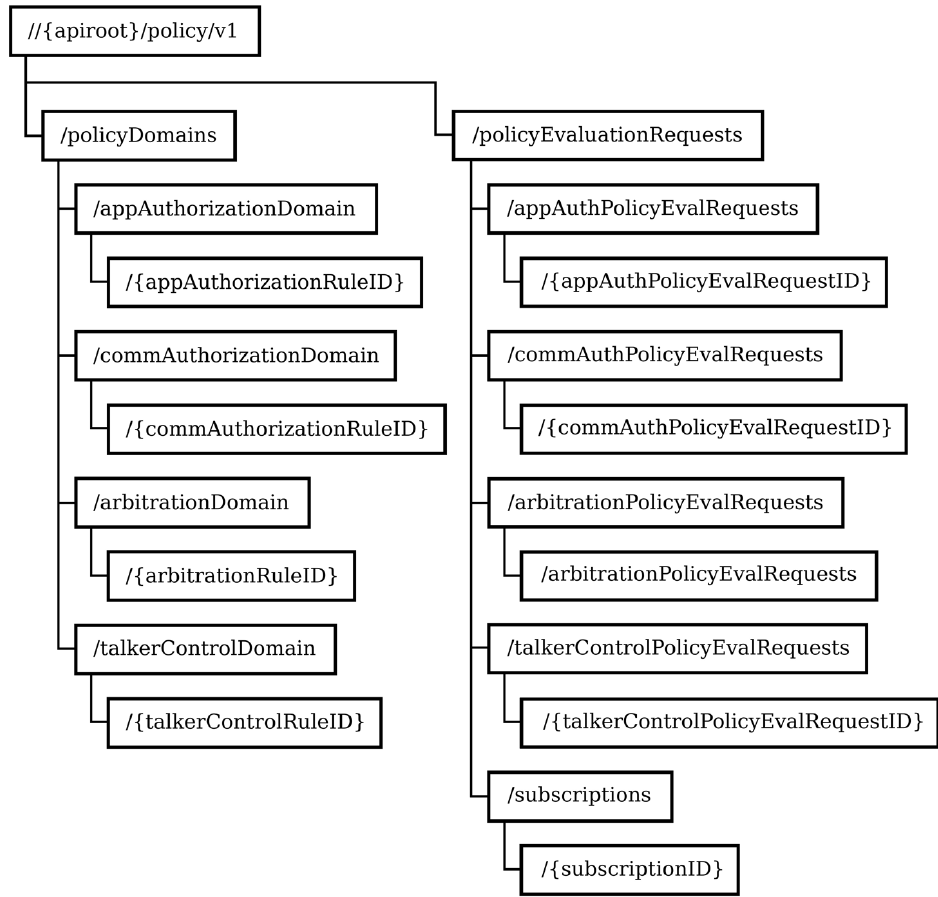
Figure 1. The structure of the URIs of the policy service resources. The policyDomains resource represents the defined railway policy domains. The GET method applied to this resource retrieves the list of policy domains and the POST method creates a new policy